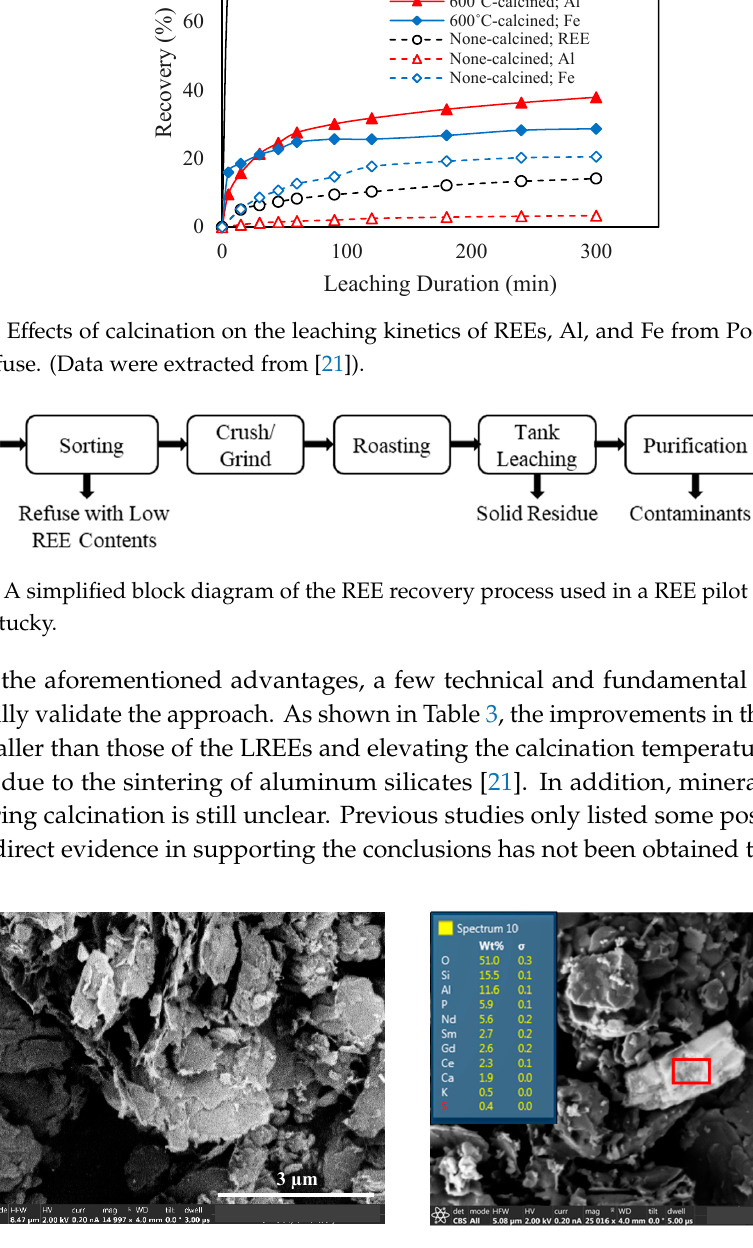
Figure 4. SEM-EDX images of a coal coarse refuse sample after thermal activation: ( A ) Disintegrated kaolinite particles; ( B ) A REE-enriched particle. [21] . kaolinite particles; ( B ) A REE-enriched particle.